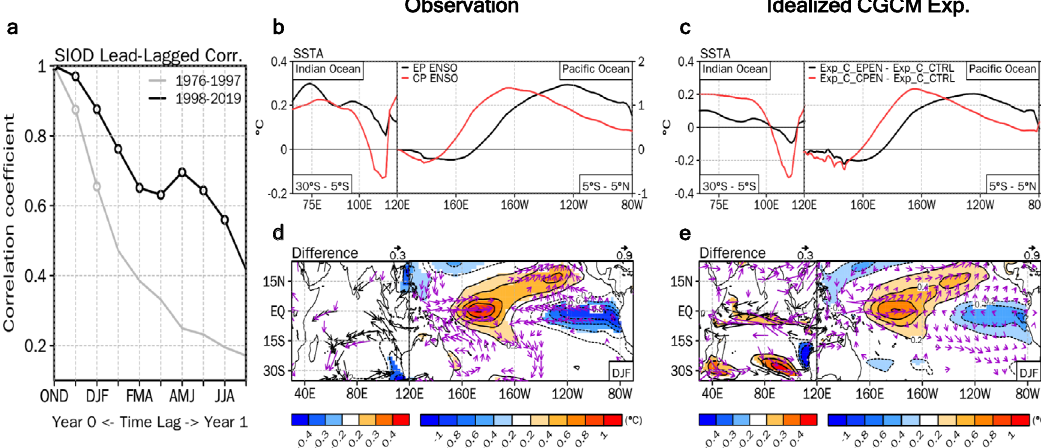
Fig. 5 | Impact of the westward-shifted ENSO on the Southern Indian Ocean Dipole (SIOD) variability after the 2000s. a Auto-lagged correlations of the boreal late fall (OND) SIOD index from the OND season to the subsequent year ’ s boreal late summer (JAS) season for 1976 – 1997 (gray line) and 1998 – 2019 (black line), respectively. The open circles in a indicate correlation coef fi cients that are statistically signi fi cant at the 95% con fi dence level. b Latitudinally averaged observed sea surface temperature (SST) (°C) anomaly composite for the Eastern Paci fi c (EP) (black line) and Central Paci fi c (CP) ENSO (red line) events during the ONDseasonfor1998 − 2019over30° – 5°SinthesouthernIndianOcean(leftpanel),